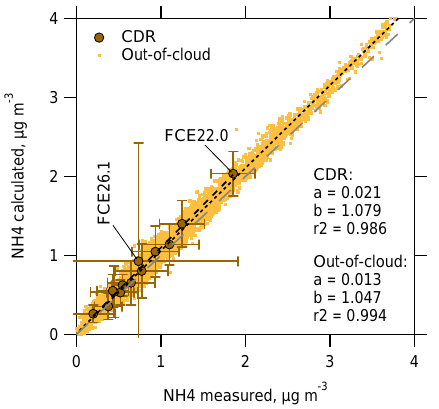
Figure 5. Predicted ammonium (assuming full neutralization of nitrate and sulfate) vs. measured ammonium, for cloud residu- als (CDRs) and out-of-cloud aerosol.